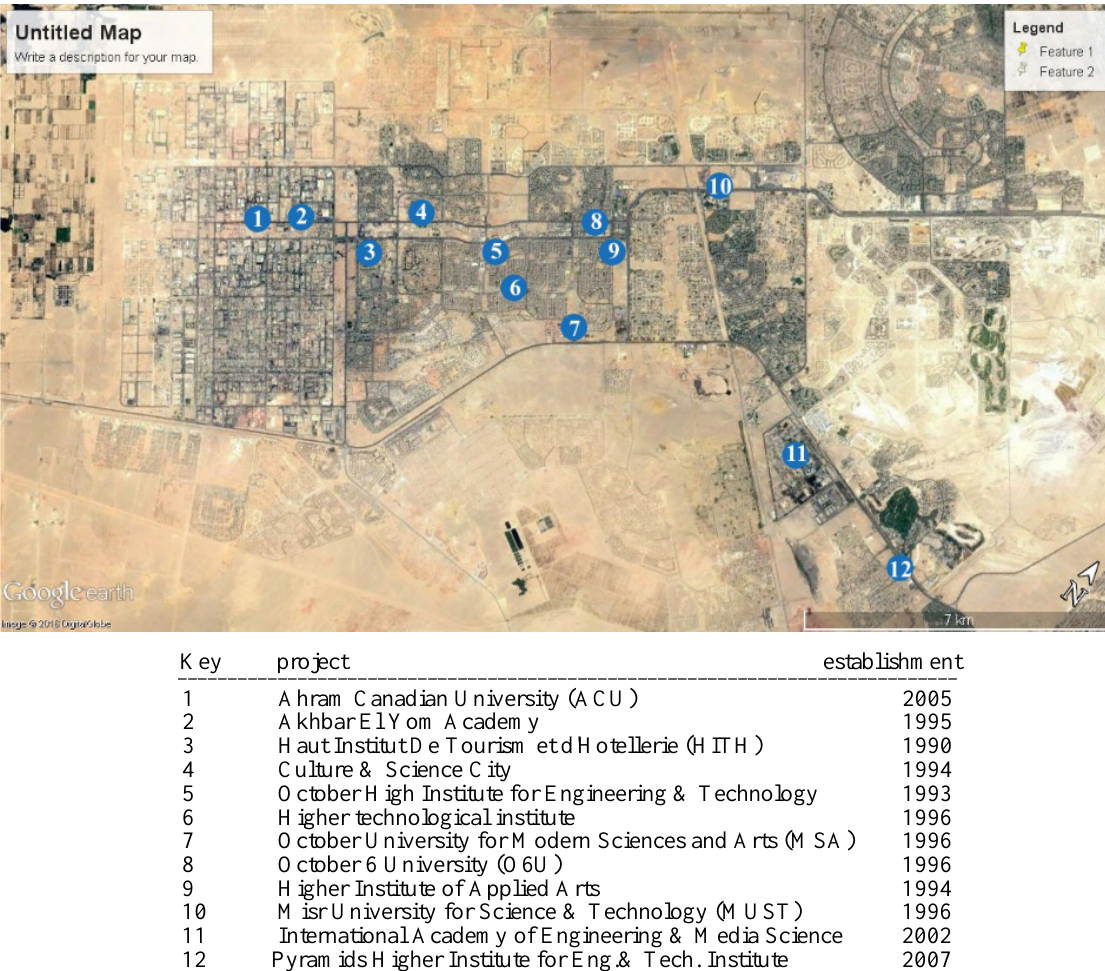
Figure 2. Higher education projects in 6 October